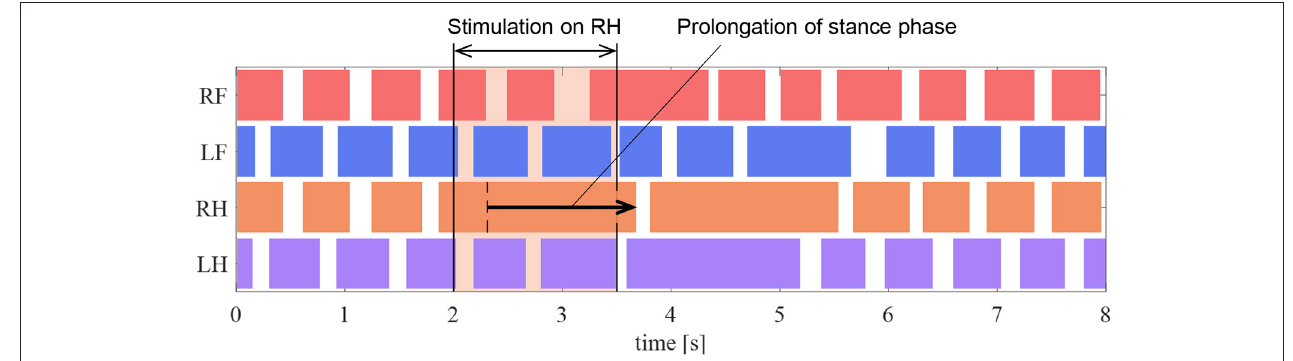
FIGURE 12 | Gait chart in the stimulation experiment of the reflex pathway. The colored regions indicate ground contact. 2 to 3.5 s. The contact time of the RH leg in Figure 12 during stimulation increased by 1.37 s compared with the normal